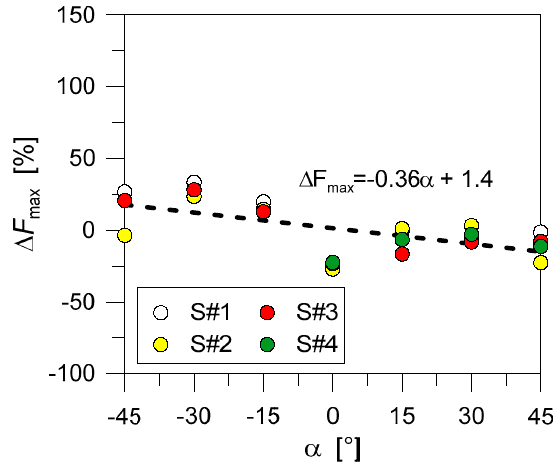
Figure 11. Percentage scatter of maximum force values for TTC joints with inclined STSs (Equation (5)), as obtained from the FE numerical analyses (ABAQUS/Explicit) and by the experiments in [6].